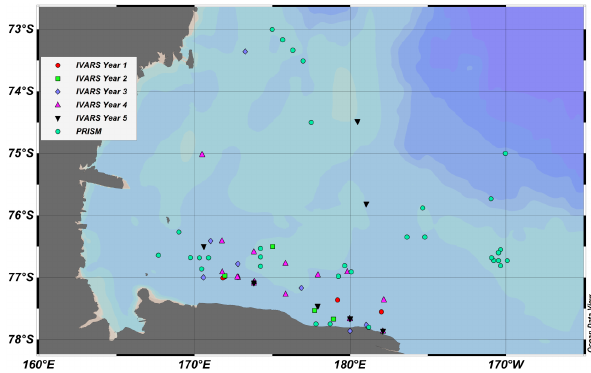
Figure 1. Map showing the location of the stations where photosynthesis–irradiance determinations were